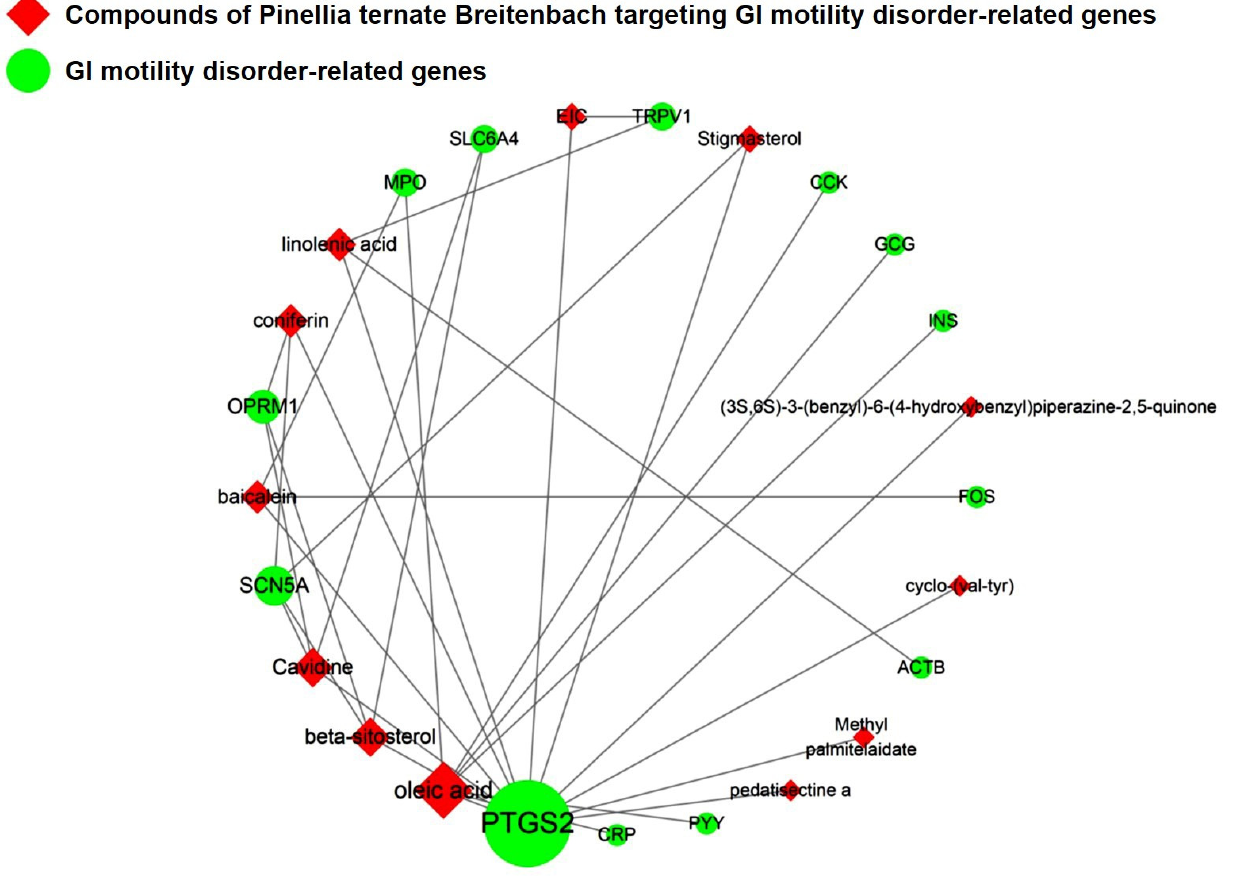
Figure 5. Network of compounds of Pinellia ternate Breitenbach and gastrointestinal (GI) motility disorder-related genes.